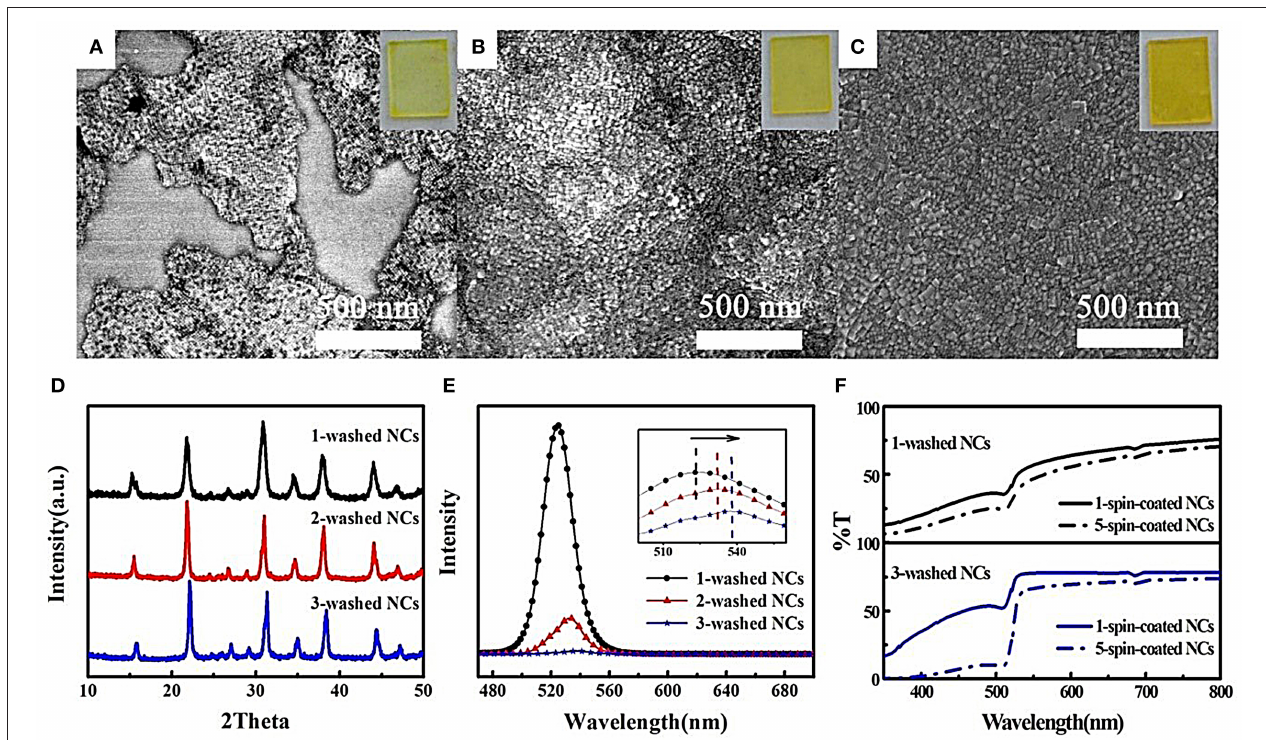
FIGURE 2 | The effects of purification times on morphology, crystal, and optical spectra of CsPbBr 3 NC films. SEM images of (A) 1 time (B) 2 times (C) 3 times washed NC films. The insets are corresponding photographs of NC films with different purification times. (D) XRD, (E) PL spectra, and (F) transmittance spectra of the NC films washed at different times. The inset in (E) is magnified PL spectra to show PL peak shift.